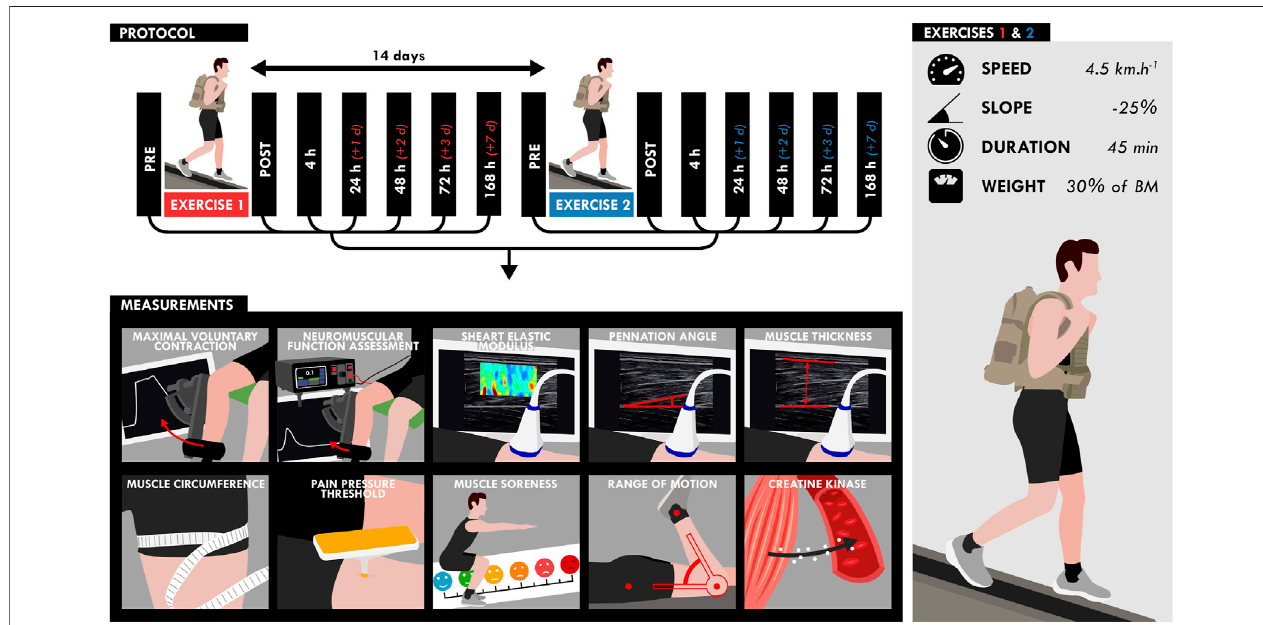
FIGURE 1 | Design of the study. Participants performed two bouts separated by 2 weeks of downhill walking on a treadmill for 45 min while carrying a load equivalent to 30% of the body mass (treadmill gradient: 25%; speed: 4.5 km.h − 1 ). All measurements (bottom) were assessed at different time points as shown on the timeline